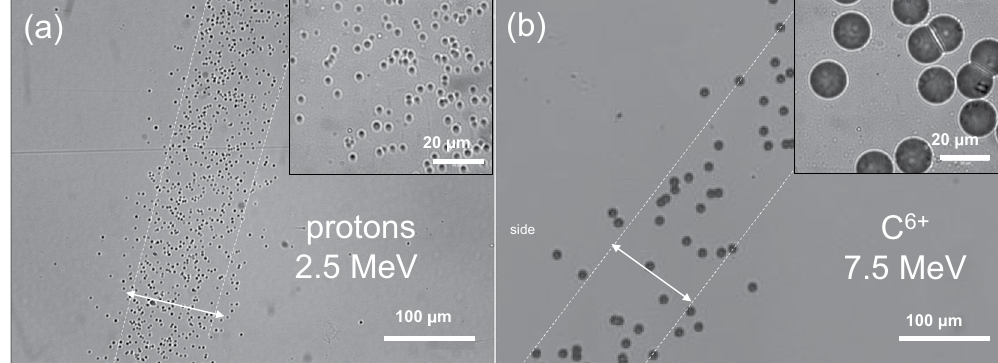
Figure 1. Microscopic images of the ion trace. The microscopic images ( 20 × magnification) of typical particle traces of ( a ) 2.5 MeV protons and ( b ) 7.5 MeV carbon ions, on the front surface of CR-39 after 9 μ m of bulk etching. The inset images are imaged with 100 × magnification. The spacing between white dashed lines is equivalent to 100 μ m, which is the aperture size of a